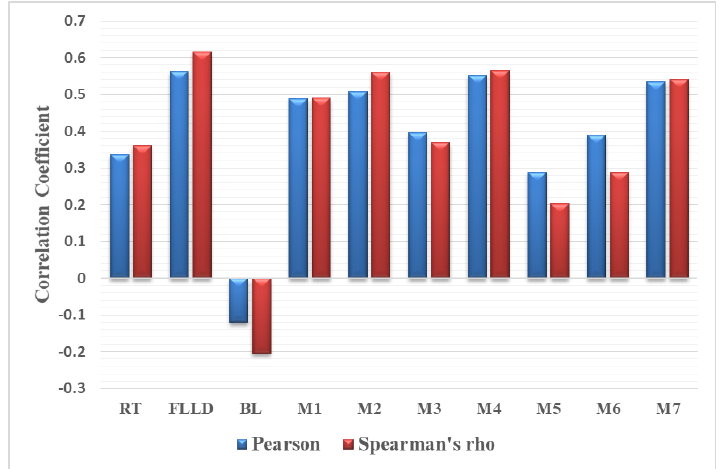
Figure 10. Correlation coefficient values of rock type (RT), former lakes and lagoon (FLLD), building load (BL), and calculated models that described in Table 1.